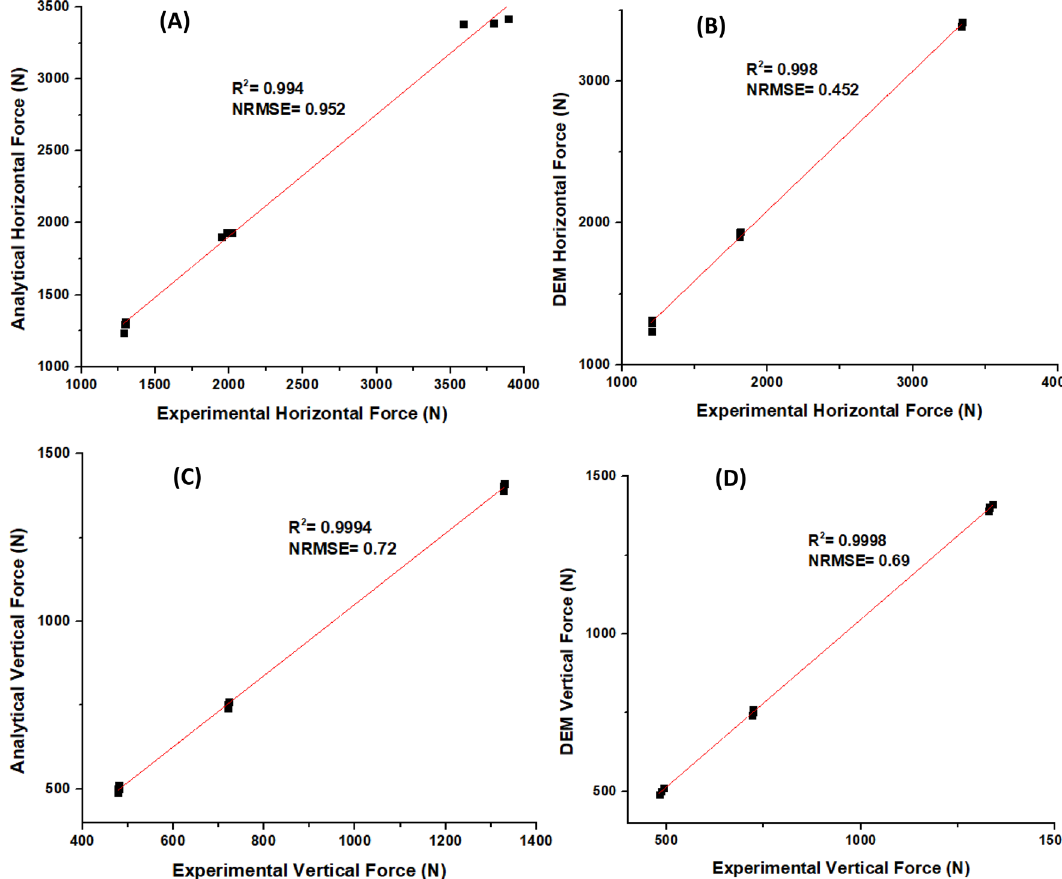
Figure 8. The linear regression plots for the predicted against measured horizontal forces ( A ) and ( B ) and vertical forces ( C ) and ( D